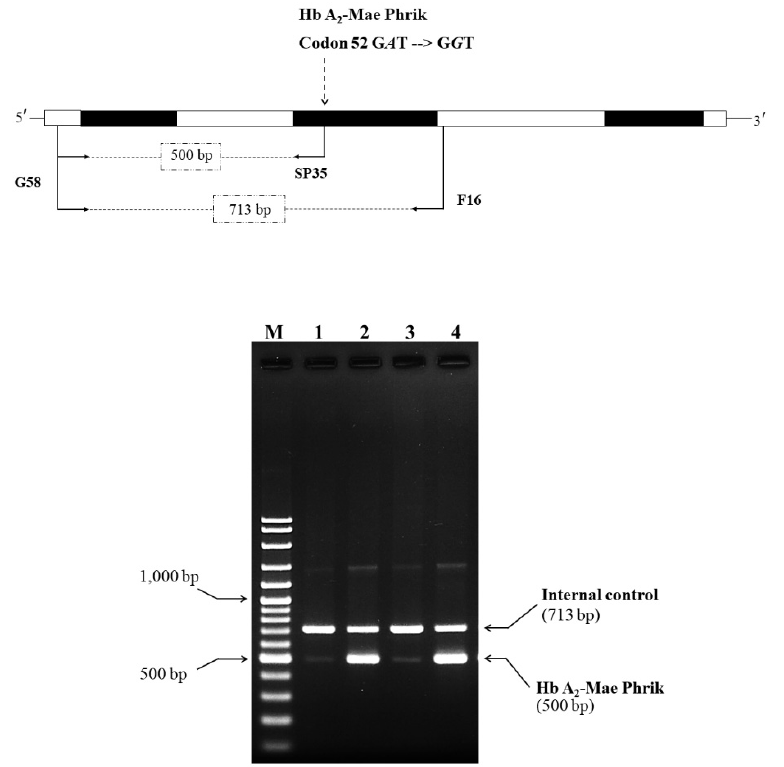
Figure 3. Identification of the Hb A 2 -Mae Phrik mutation by allele-specific PCR assay. The locations and orientations of primers G58 and F16 that produce the 713 bp specific fragment of the δ -globin gene. The Hb A 2 -Mae Phrik fragment is amplified by G58 and SP35, with a length of 500 bp. M represents the GeneRuler 100 bp Plus DNA marker. Lane 1: normal DNA; lanes 2 and 4: Hb A 2 -Mae Phrik; lane 3: normal individual.